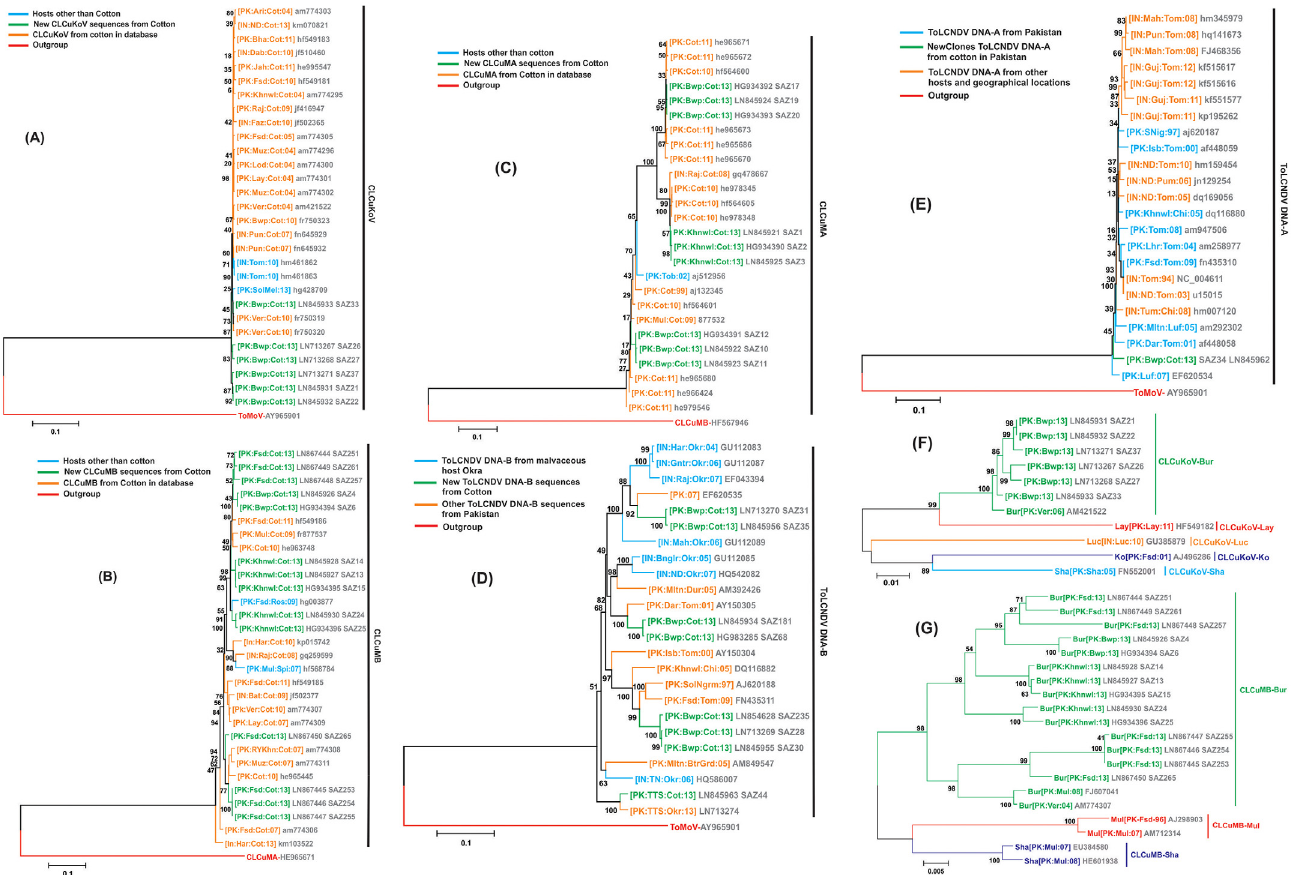
Fig 2. Phylogenetic analysis of the sequences of begomoviruses, and satellites obtained in the study. Trees were constructed from alignments of the sequences of (A and F) Cotton leaf curl Kokhran virus (CLCuKoV), (B and G) Cotton leaf curl Multan betasatellite (CLCuMB), (C) Cotton leaf curl Multan alphasatellite (CLCuMA), (D) Tomato leaf curl New Delhi virus (ToLCNDV) DNA-B and (E) ToLCNDV DNA-A using the Neighbor-Joining method. Isolates in green were obtained in the study described here. The numbers at nodes represent percentage bootstrap scores (1000 replicates). The strain descriptors (in square brackets) in each case give country, location, host and year of sampling. For each isolate the database accession number is given. The trees were arbitrarily rooted on the sequence of Tomato mottle virus (ToMoV) (A, D and E), CLCuMA (B) and CLCuMB (C) as outgroup. The strains of CLCuKoV given in panel F are Burewala (Bur), Layyah (Lay), Lucknow (Luc), Kokhran (Kok) and Shadadpur (Sha). The strains of CLCuMB given in panel G are given as Burewala (Bur), Multan (Mul) and Shadadpur (Sha).